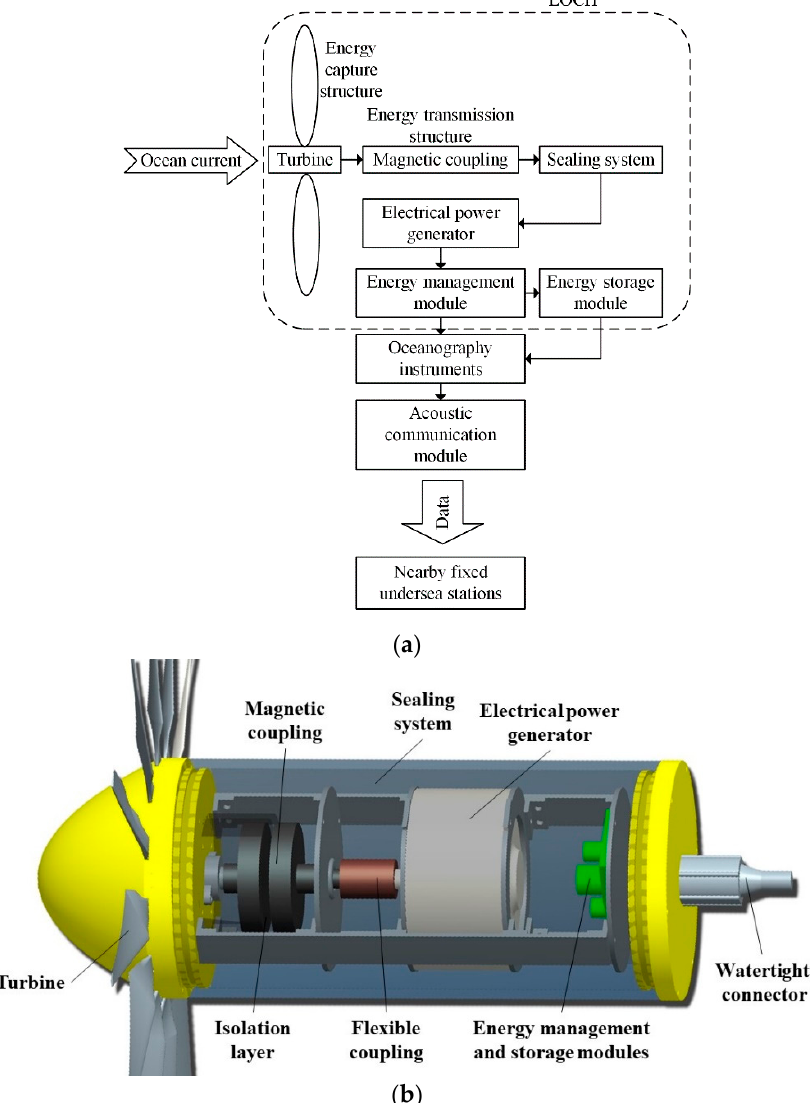
Figure 1. The principle ( a ) and the overall design ( b ) of the proposed LOCH.